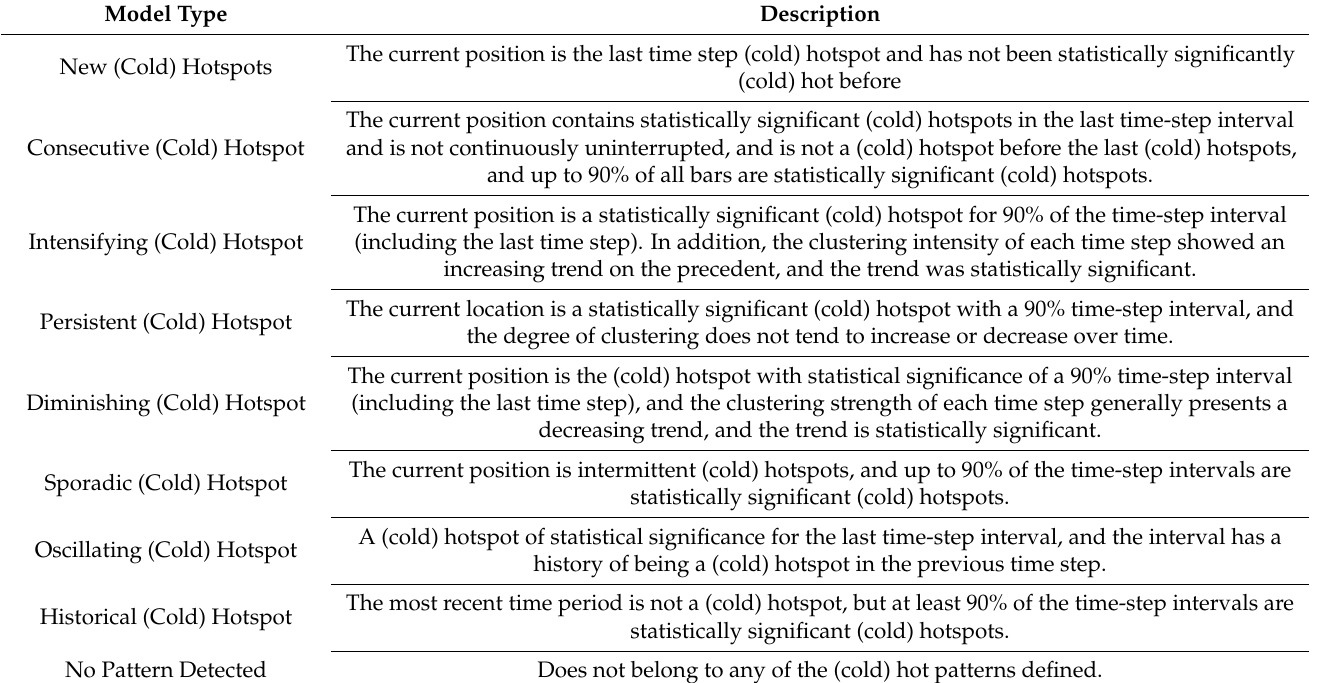
Table 6. Significant cold- and hot-spots trend